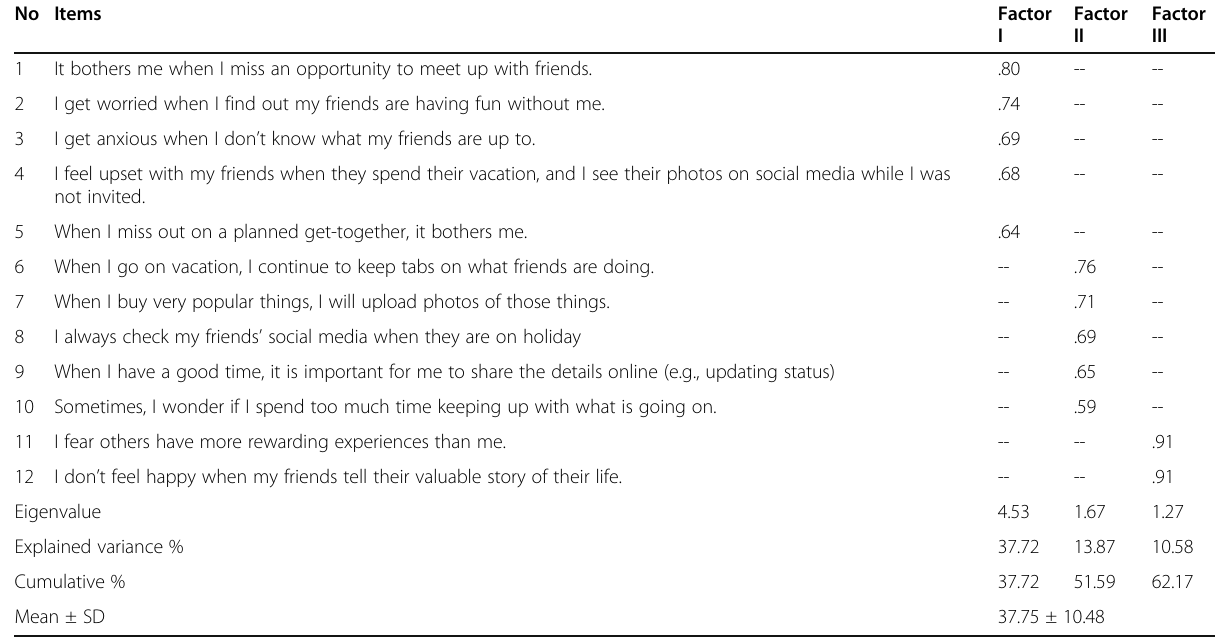
Table 6 Exploratory factor analysis: factor loadings for the FoMO, principal components, varimax rotation, eigenvalues, and percentage of explained variance (second